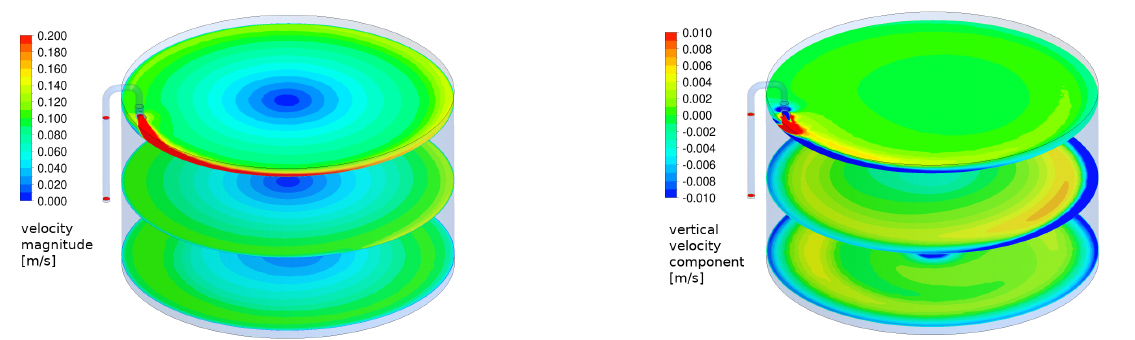
Figure 7. ( left ) Contours of velocity magnitudes in three horizontal planes in the fish tank. ( right ) Contours of vertical velocity components (positive values represent upward direction).